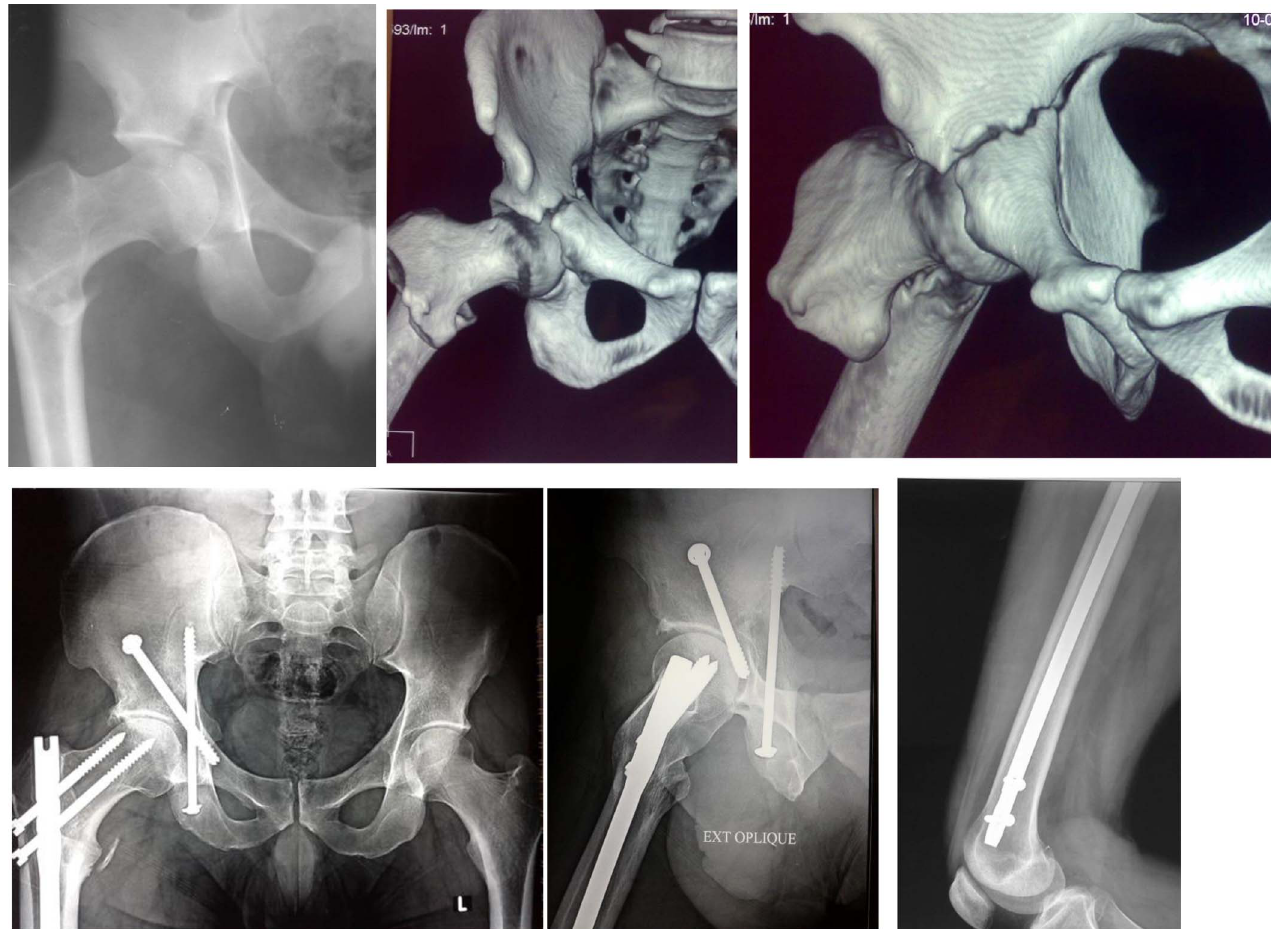
Figure 1. Case example showing ipsilateral acetabular fracture and proximal femoral fracture. Top row: Preoperative X-ray and 3D- reconstruction CT scan. Bottom row: X-rays at 7 years postoperative. Table 1. OHS/OKS and EQ-5D value index for the included patients. N